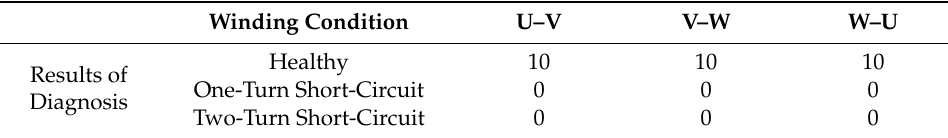
Table 6. Diagnostic results for the 1.5-kW motor 3